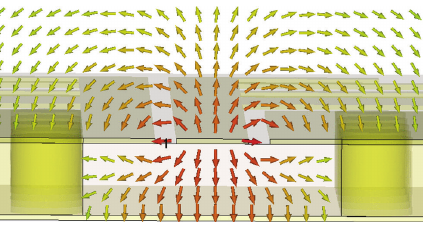
Figure2:Simulatedelectricfielddistributionofthedominantmode in the cross-section of the